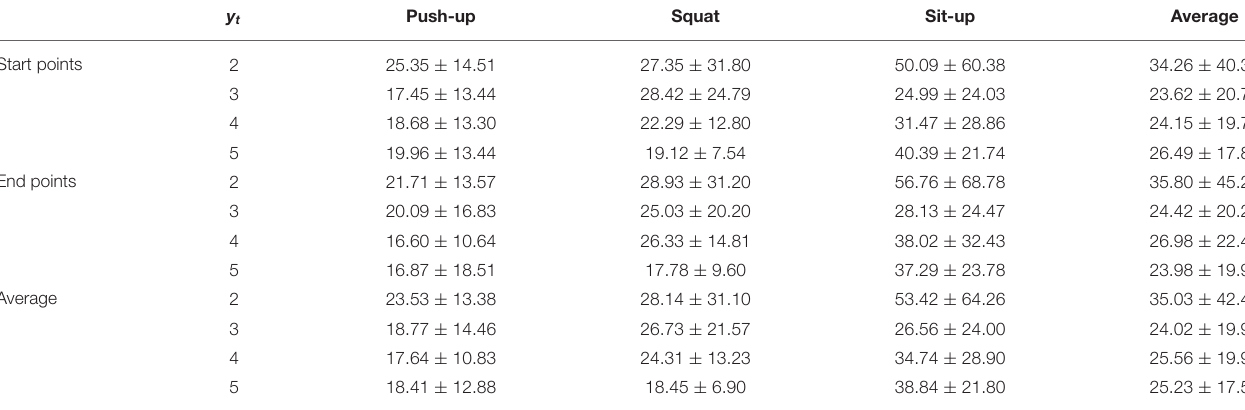
TABLE 6 | MAE when detecting the start/end time of each occurrence for each y t value (samples). y t Push-up Squat Sit-up